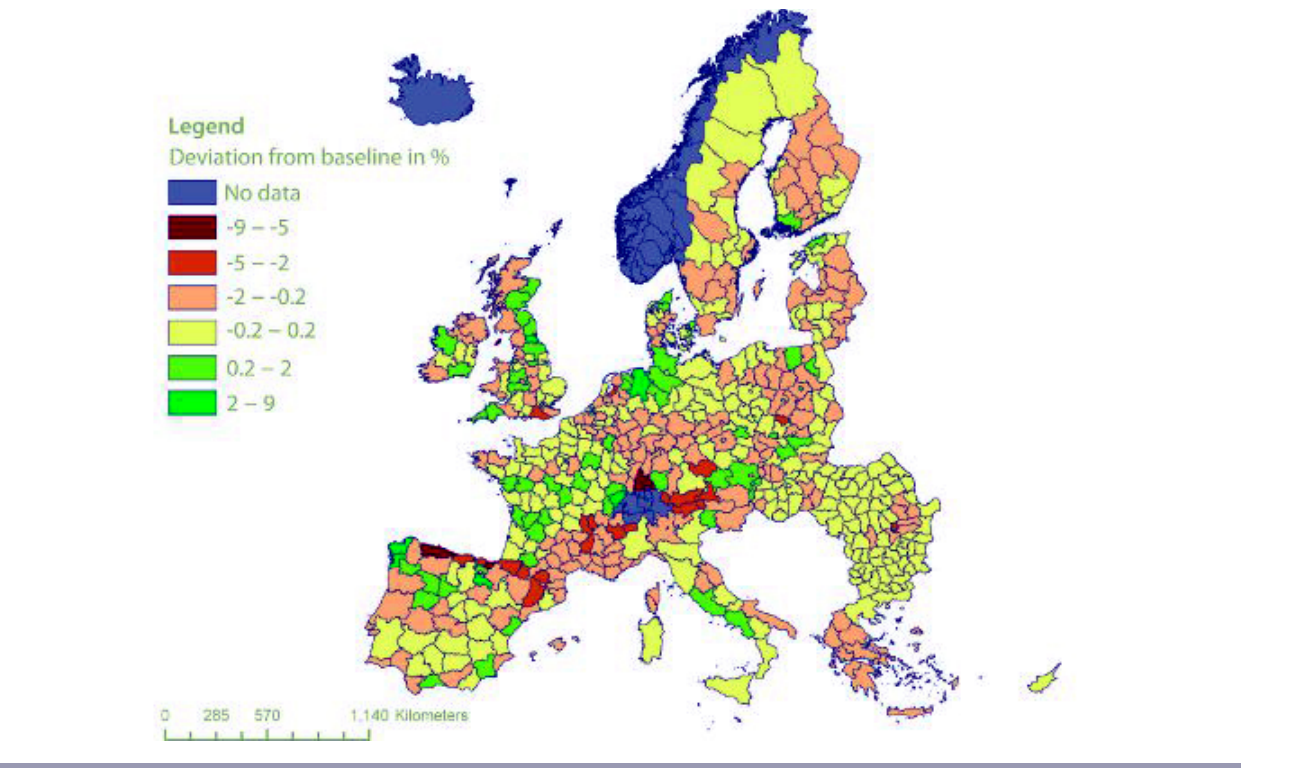
Fig. 4 . Common Agricultural Policy financial reform scenario: 100% cut of Common Agricultural Policy first pillar measures (market support and direct income support), and re-investment of savings in research and development. The map shows the impacts of the policy on grassland area in terms of absolute changes of the area share of grassland compared to the baseline on NUTS-X level in